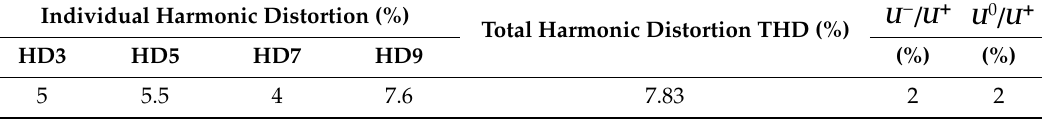
Table 2. LV network distortion and imbalance limits according to EN 50160 and EN 61000-2-2:2002. U − / U + U 0 / U + Individual Harmonic Distortion (%) Total Harmonic Distortion THD (%) HD3 HD5 HD7 HD9 (%) (%) 5 5.5 7.83 2